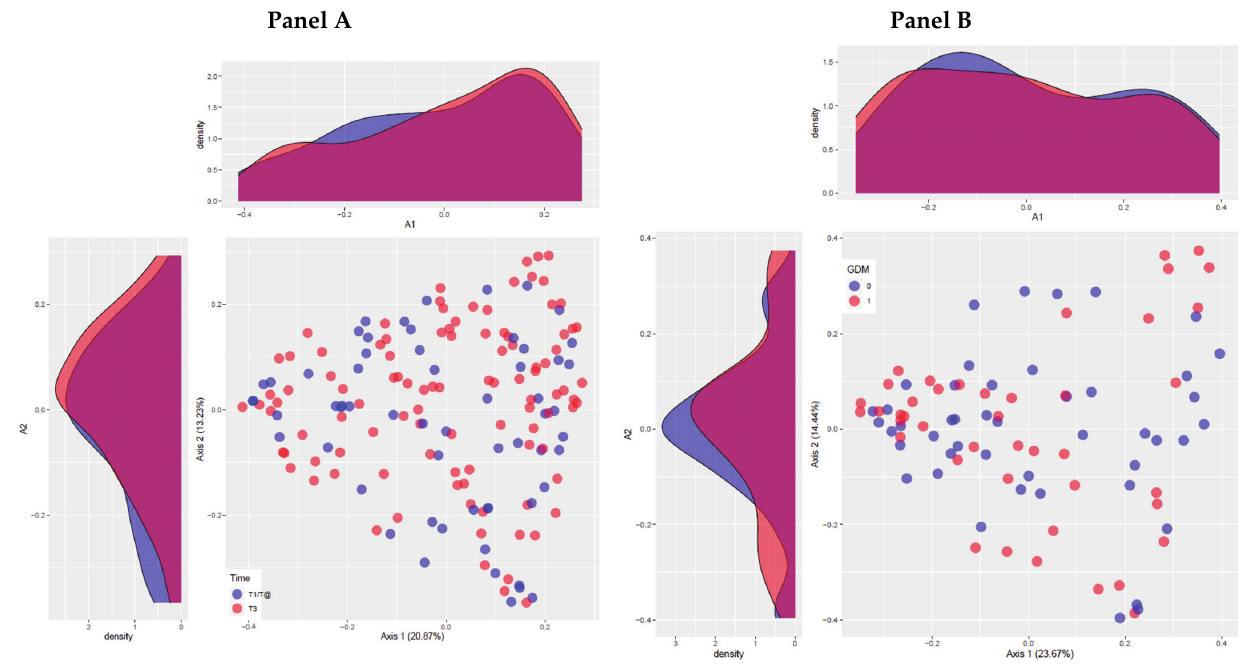
Figure 2. Microbiota structure of the total sample (panel ( A )) and groups of normal and GDM participants (panel ( B )) across gestation. Axes percentages represent the amount of variation in the data explained by the axis, calculated from the eigenvalues of PCoA (main coordinate analysis). The axes intervals represent the relative dissimilarity present between the samples. Time, trimester of pregnancy: T1/2, first or second trimesters of gestation; T3, third trimester of gestation. GDM: 0, without GDM; 1, with GDM.